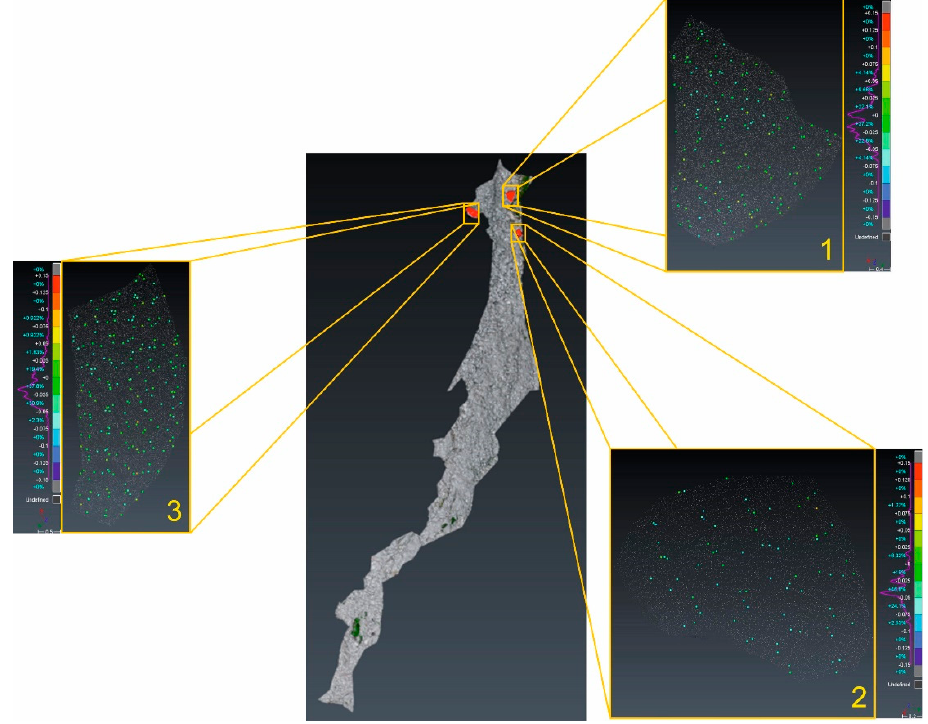
Figure 20. Localization of boulders and comparison of UAS and ALS.